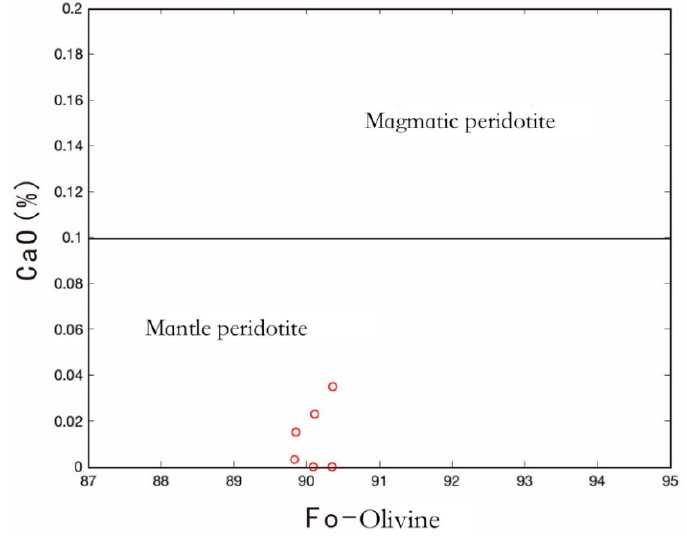
Figure 9. CaO-Fo graph of olivine [41].